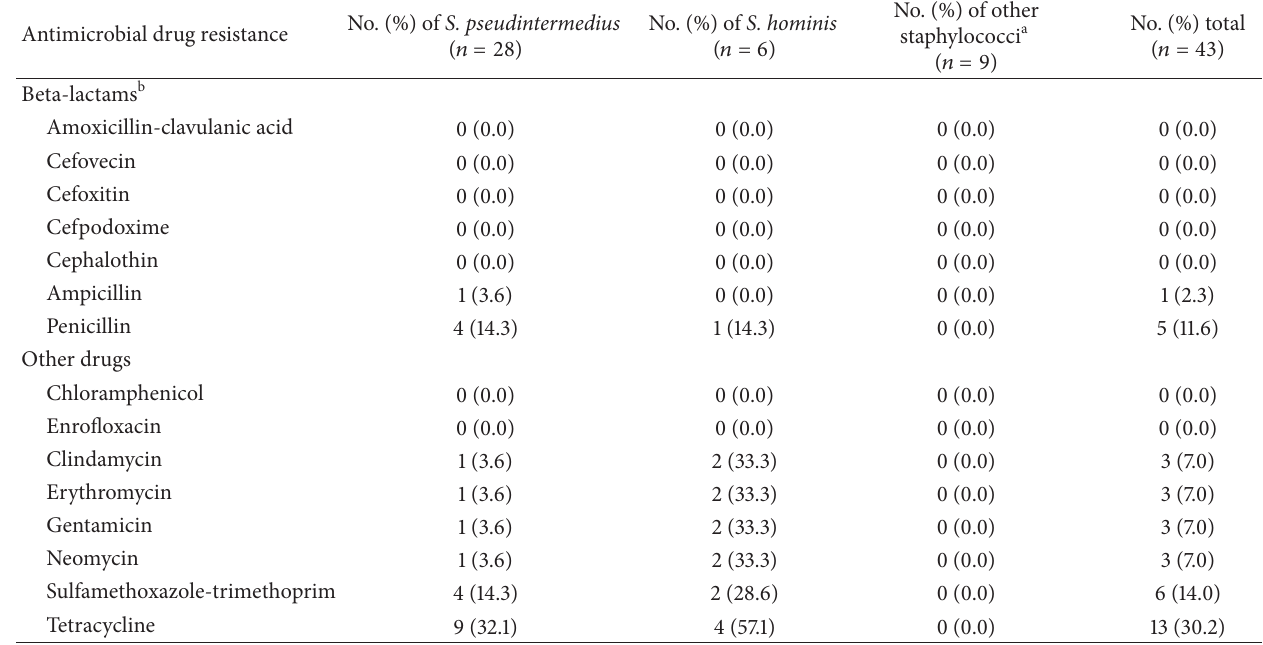
Table 2: Antimicrobial resistance patterns of staphylococci from canine pyoderma cases in Grenada, West Indies. No. (%) of S. pseudintermedius No. (%) of S. Antimicrobial drug resistance ( 𝑛 = 28 )